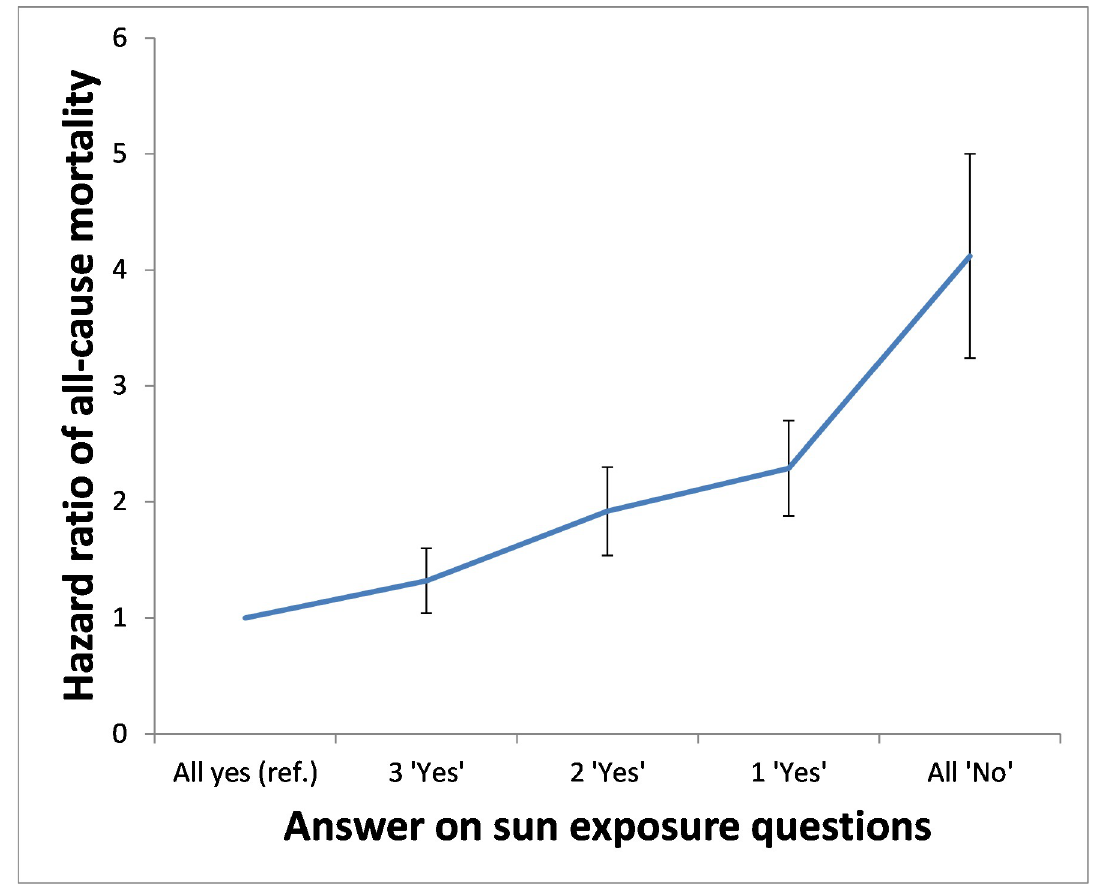
Fig 2. Sun exposure habits were classified by the number of “yes” answers to the following questions: (i) Do you sunbathe during the summer? (ii) Do you sunbathe during the winter, such as during holidays to the mountains? (iii) Do you use tanning beds? (iv) Do you go abroad on holiday to swim and sunbathe? Every “No” on the four sun exposure questions was related to � 20% increased all-cause death rate in the next 25 years, as compared to those answering yes on more questions. Significance of difference between all five groups p = < 0.001, 95% confidence intervals are